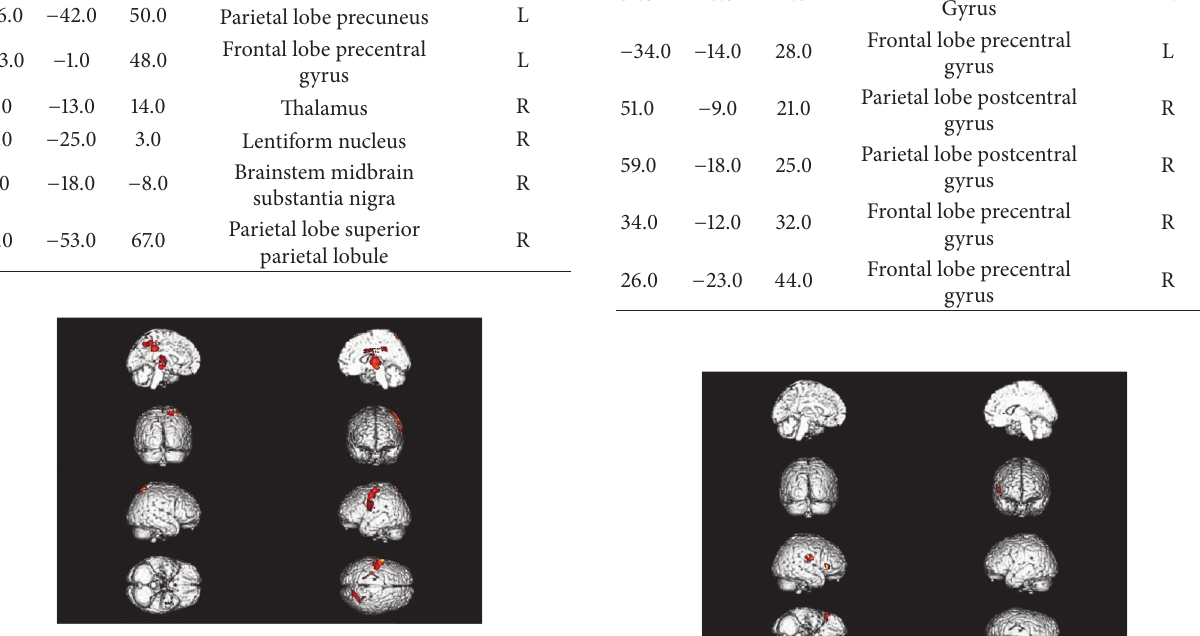
Figure 1: SPM hypometabolic maps comparing all the affected patients (DG) versus the control group (CG) overlaid on the structural MR template included in SPM5.